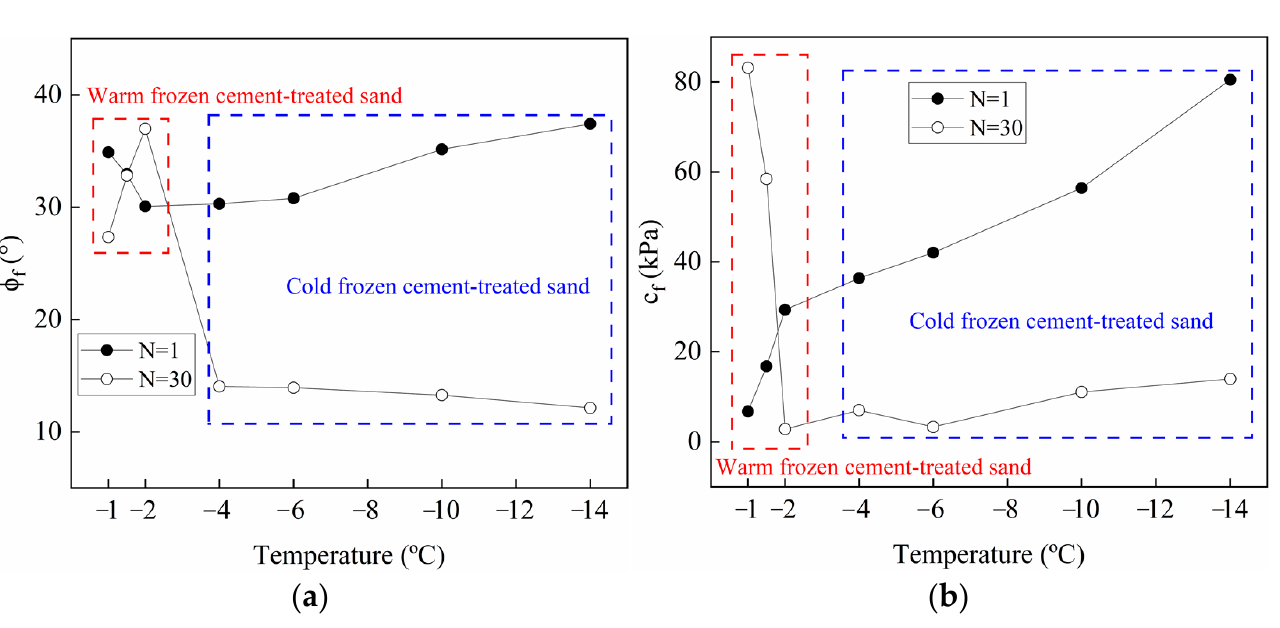
Figure 11. Variation of friction angle and cohesion for N = 1 and N = 30 at different temperatures. ( a ) Cohesion; ( b ) friction angle.